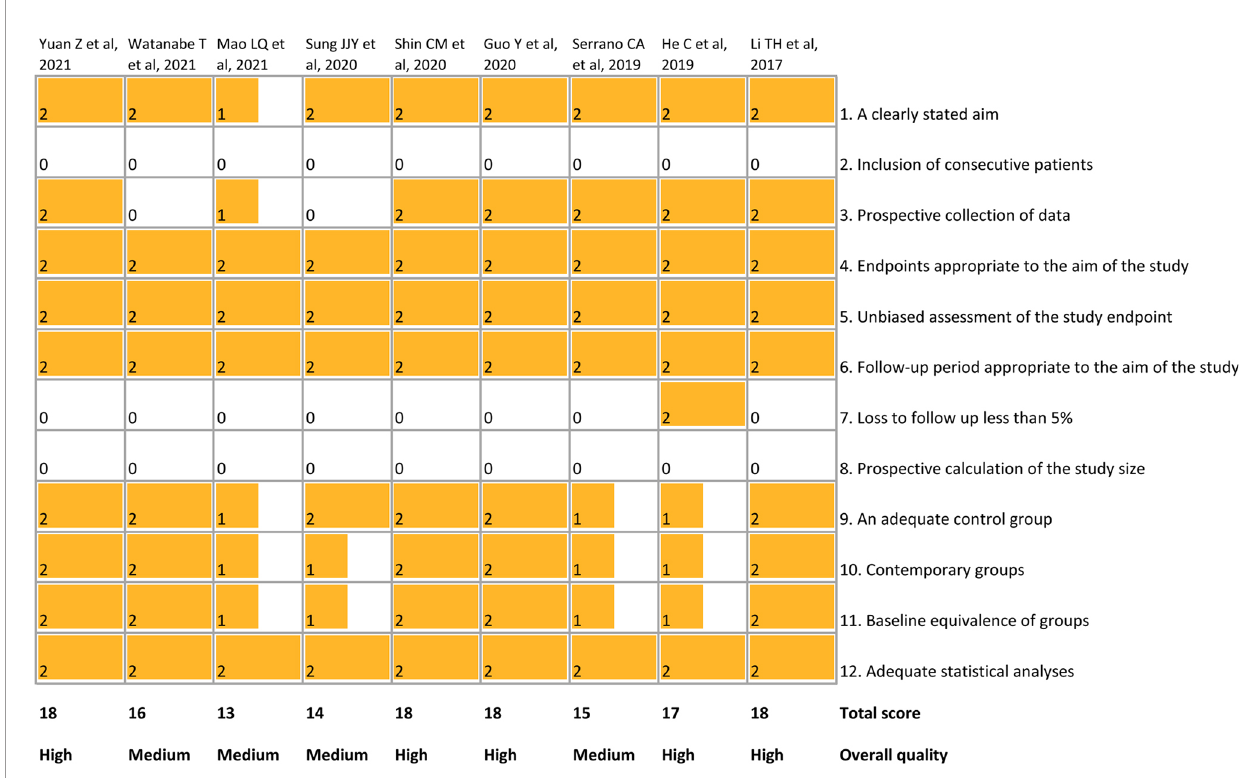
FIGURE 2 | Quality assessment of included studies using MINORS. MINORS, Methodological Index for Non-Randomized